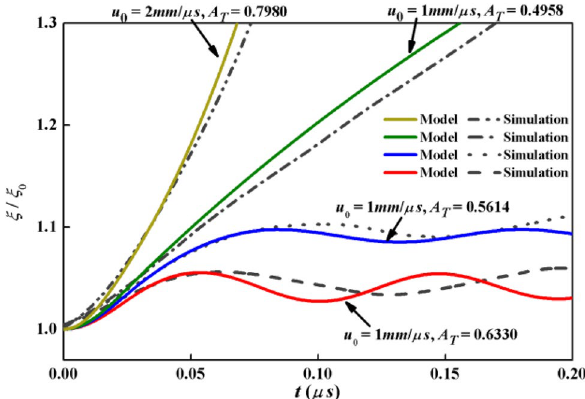
Figure 4. Growth factors versus time by model and simulation of KHI between perfectly EP solid and ideal